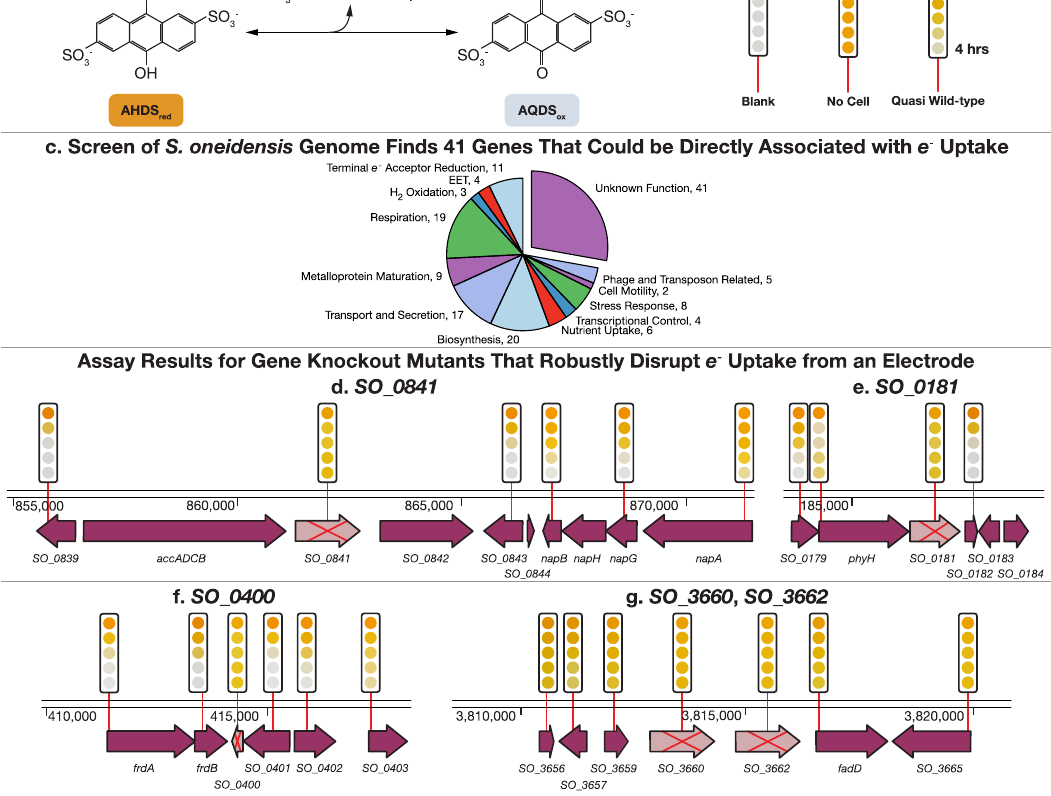
Fig. 2 A genome-wide screen of S. oneidensis fi nds 149 genes that disrupt electron uptake. All 3712 members of the S. oneidensis whole-genome- knockout collection were screened for electron uptake capability with AHDS red oxidation assays, either fumarate or nitrate as a terminal electron acceptor. In total, 149 genes disrupt AHDS red oxidation with fumarate, nitrate and in many cases both as a terminal electron acceptor (note, only one terminal electron acceptor is used at once). a AHDS red /AQDS ox redox reaction is used as a proxy for extracellular electron uptake. AHDS red changes color from orange to clear when oxidized. Electrons are transferred to either a fumarate or nitrate terminal electron acceptor by S. oneidensis . b Blank, no-cell and quasi-wild-type (transposon mutants that contain a kanamycin cassette but have no effect on AHDS red oxidation) controls. The color of the AHDS red dye is recorded photographically and displayed at 1-hour intervals after the start of the experiment by a series of colored circles above each gene. Further information on this assay can be seen in Fig. S1 and “ Materials and Methods ” . Data shown use fumarate. c The electron-uptake assay associates 149 genes with electron uptake. Electron uptake failure can be explained in 108 cases, but in 41 cases, it fails for unknown reasons, implicating these genes in an uncharacterized electron-uptake process. Full screening results and functional categorizations are shown in Supplementary Data 1. d – g AHDS red oxidation assay results are shown for selected mutants containing deletions of genes highlighted in this article that robustly disrupt electron uptake from a cathode (the selection process for these fi ve mutants is shown in Fig. 3) (pink arrow with a red cross through the center) along with gene-disruption mutants for the surrounding genes (purple arrow, with a red line indicating the location of the transposon insertion). All time courses are from experiments using fumarate as a terminal electron